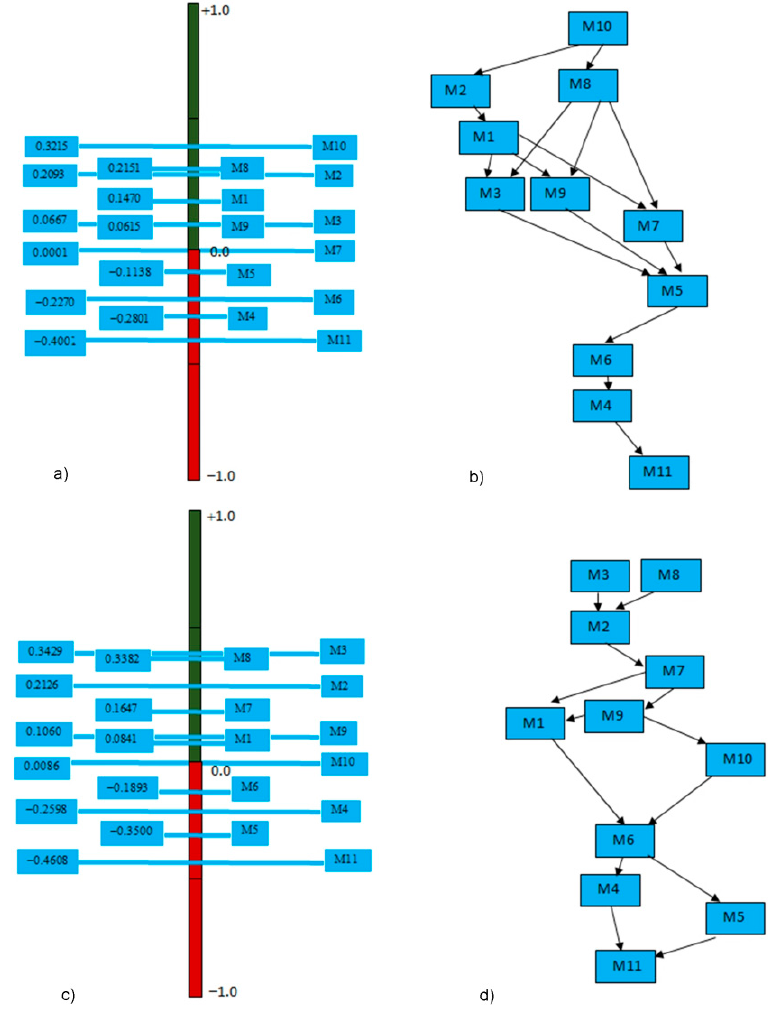
Figure 3. Ranking results for ( a ) WP complete ranking; ( b ) WP network partial ranking; ( c ) CP complete ranking; ( d ) CP network partial ranking.